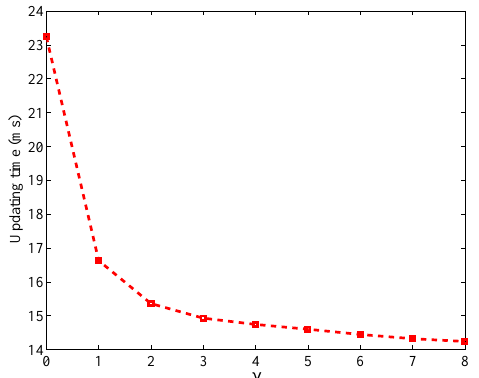
Figure 10. Updating time versus threshold in the binary